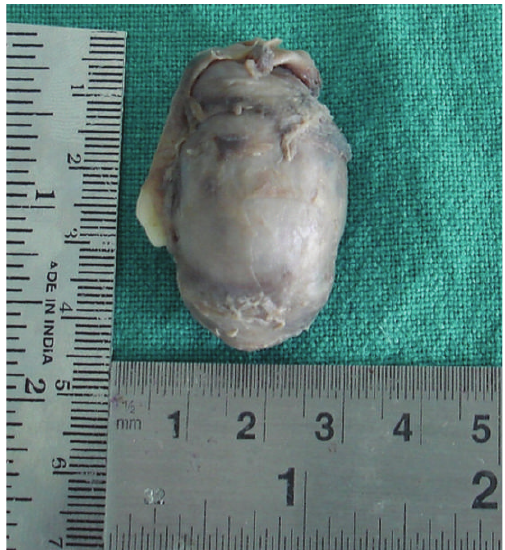
Figure 3: Surgical gross revealing a cystic lesion with embedded canine.